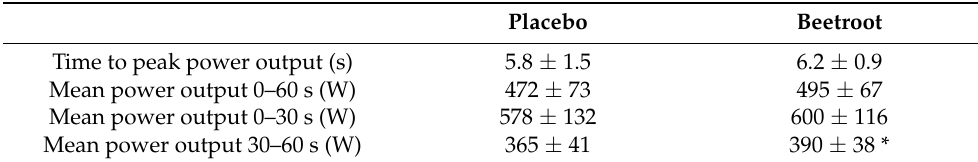
Table 2. Time to peak power output, peak power output and mean power output variables during a maximal-intensity 60 s end-sprint following 2 h moderate-intensity exercise after ingestion of nitrate-rich and nitrate-depleted beetroot